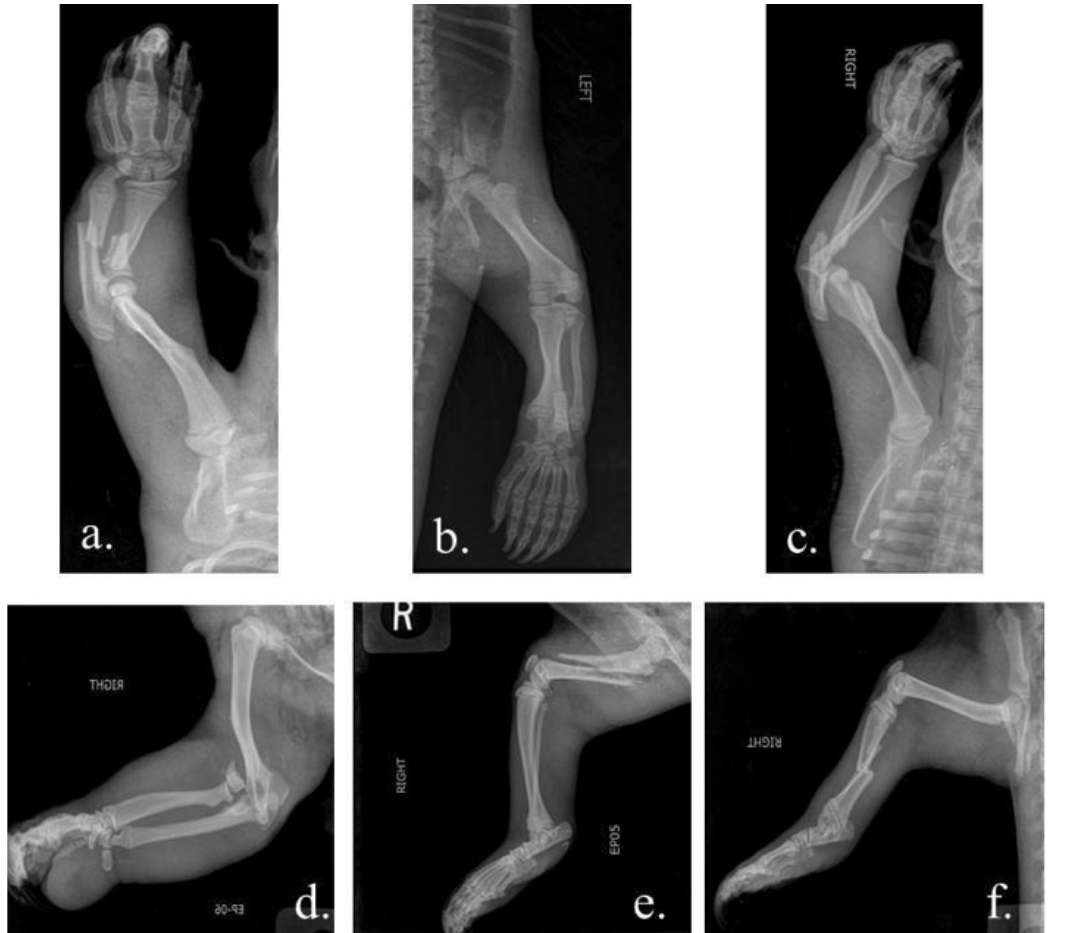
Figure 1. Selected x-rays of fractures in different bones from the ten roadkill T. mexicana collected between April and July 2016, on different roads in Costa Rica. Anteroposterior and lateral projections are represented. a — diaphyseal radio-ulnar fracture | b — distal ilial fracture | c